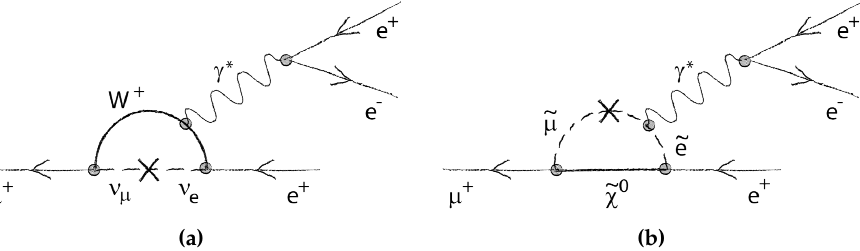
Figure 1. Feynman diagram of the decay of the muon into three electrons ( a ) via neutrino mixing in the Standard Model and ( b ) via slepton mixing in the SUSY model.